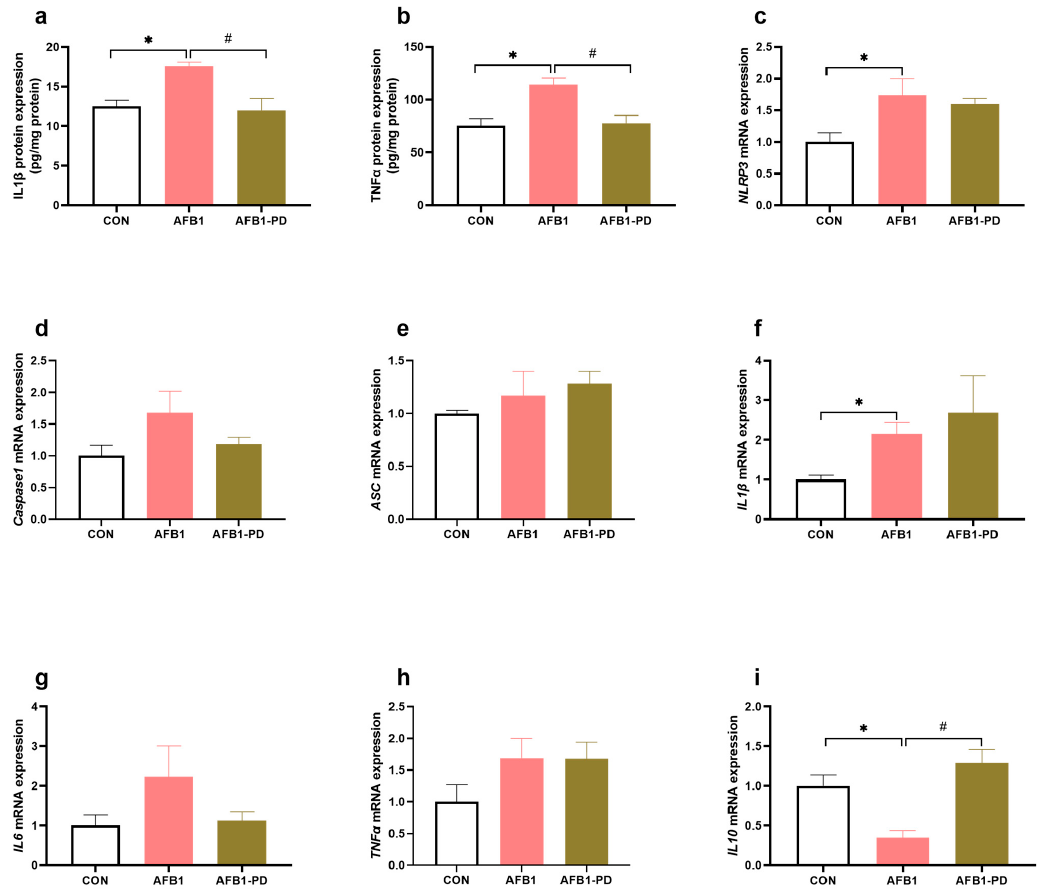
Figure 3. Polydatin (PD) inhibits hepatic inflammation in aflatoxin B1 (AFB1) mice. ( a , b ) The protein expression of interleukin 1 beta (IL1 β , n = 6) and tumor necrosis factor alpha (TNF α , n = 6); ( c – i ) the mRNA expression of nucleotide-binding and oligomerization domain-like receptor family pyrin domain-containing 3 ( NLRP3 ), apoptosis-associated speck-like protein ( ASC ), interleukin 6 ( IL6 ), IL1 β , TNF α and IL 10 (n = 5) . CON, mice are given 0.5% dimethyl sulfoxide; AFB1, mice are given 300 µg AFB1/kg body weight/day; AFB1-PD, mice are given 100 mg PD/kg body weight/day and then exposed to AFB1. Results are represented as mean and standard error. * p < 0.05 when